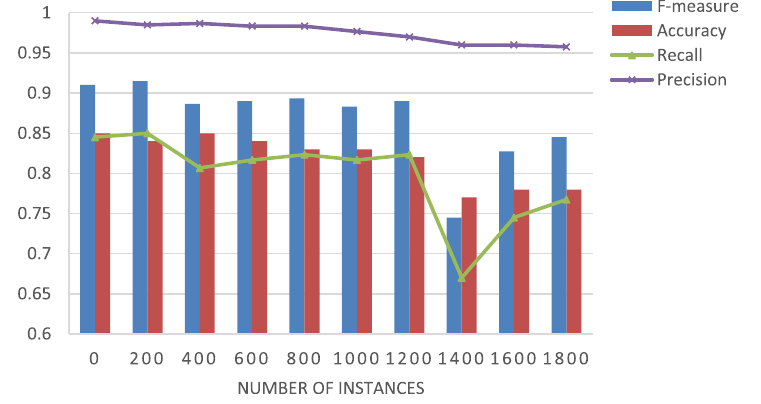
Fig. 6. Sanders dataset: Evolution of F -measure, Accuracy, Recall, and Precision values according to the number